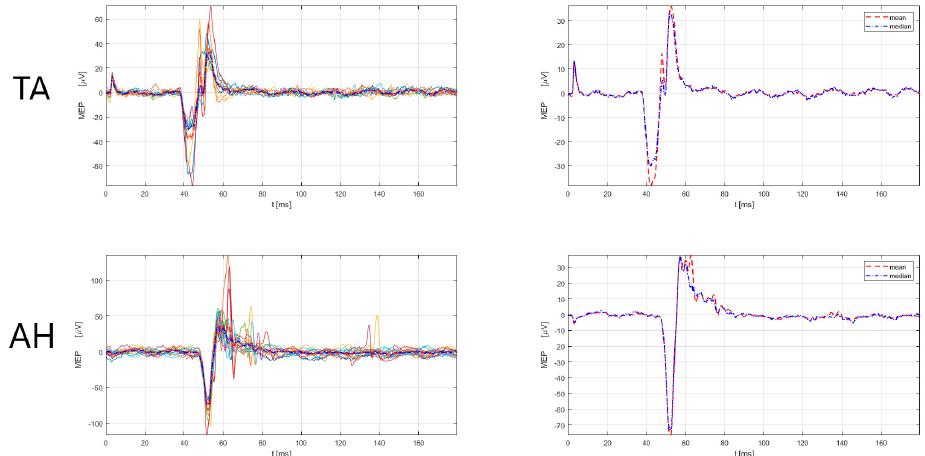
Figure 5. MEP responses for lower extremity (TA, AH) muscles, left side for No5 subject. Left: superimposed responses, Right: mean and median responses. TA = tibialis anterior, AH = abductor hallucis. Legend: the red dashed line denotes the mean response of all MEPs, and the blue dash-dotted line represents the median response of all MEPs. MEP latency and amplitude estimation was performed by a custom-made Matlab script (R2021a) using an automatic algorithm, developed by Šoda et al. (2020) [68].